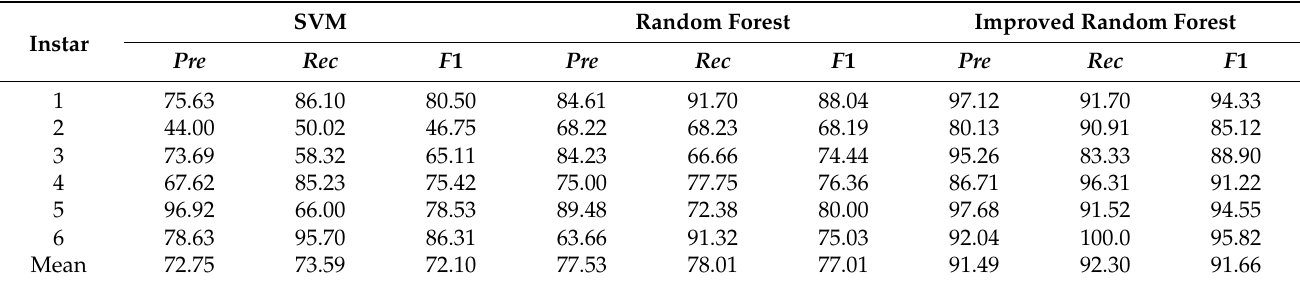
Table 2. The identification results of FAW larval instars using three models. Random Forest Improved Random